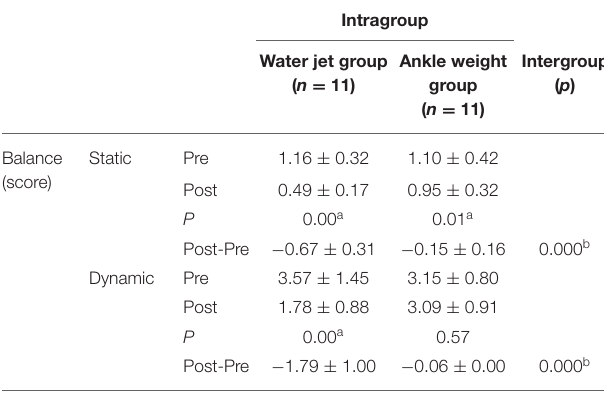
TABLE 2 | Changes in static and dynamic balance within each group and between the two groups.